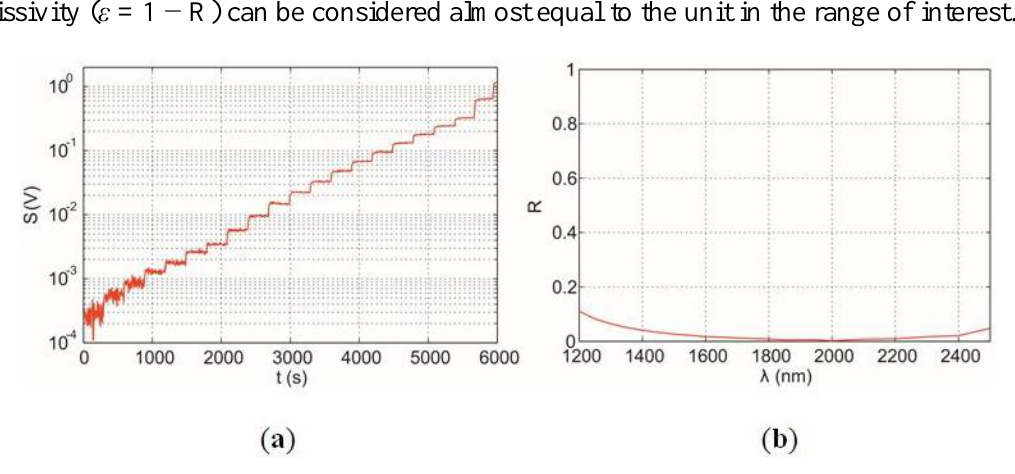
( b ) Spectral reflectance of ferromagnetic black body used in calibration of sensor. Spectral